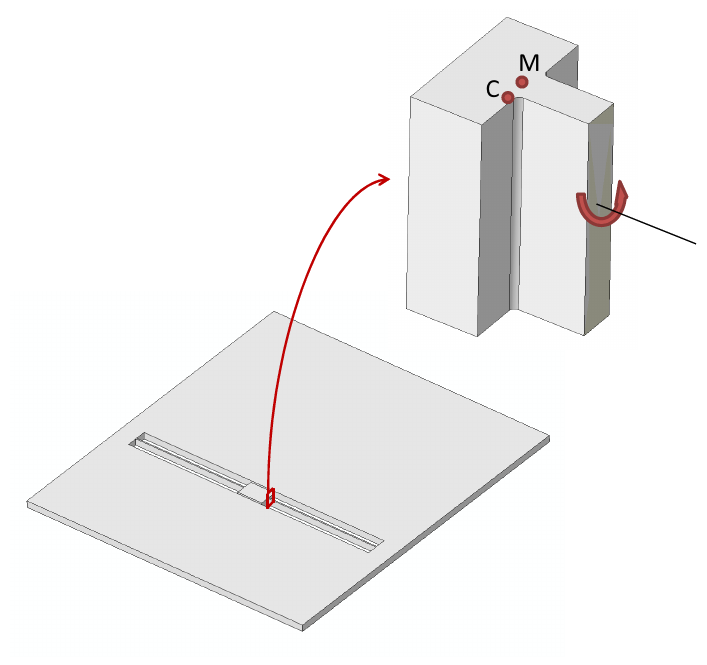
Figure 11. Model of the plate-spring connection region subjected to a torque, as adopted for the calculation of the stress intensity factor at the re-entrant corners.